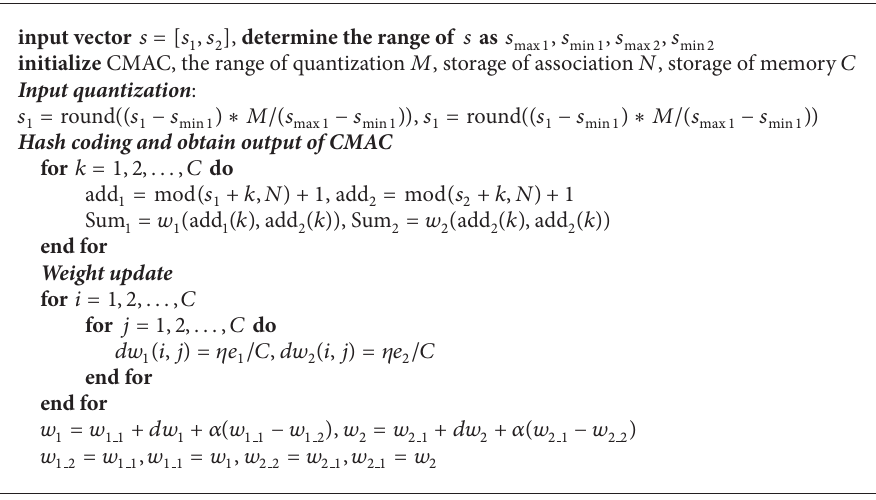
Algorithm 2: The process of CMAC neural network. (Notation: the input is sliding surface and the output is the compensation control vector.)